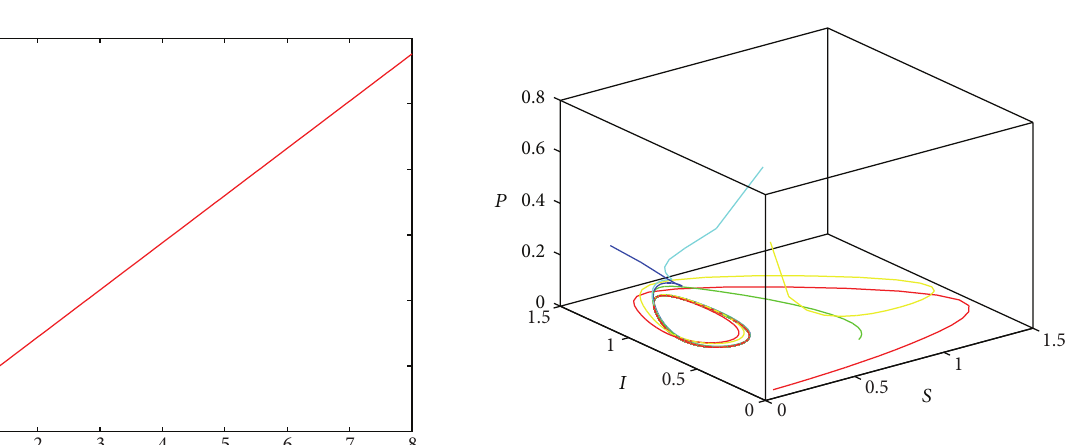
Figure 4: The existence of periodic solution of system (2). 𝑑(𝑡) = 0.5 + 0.2 sin (2𝑡) , Λ(𝑡) = 0.6 + 0.5 sin 𝑡 , 𝛽(𝑡) = 3.2 + sin 𝑡 , 𝑒(𝑡) = 0.6 + 0.2 sin 𝑡 , and 𝑓(𝑡) = 0.05 + 0.045 sin 𝑡 . The periodic solution is globally attractive.